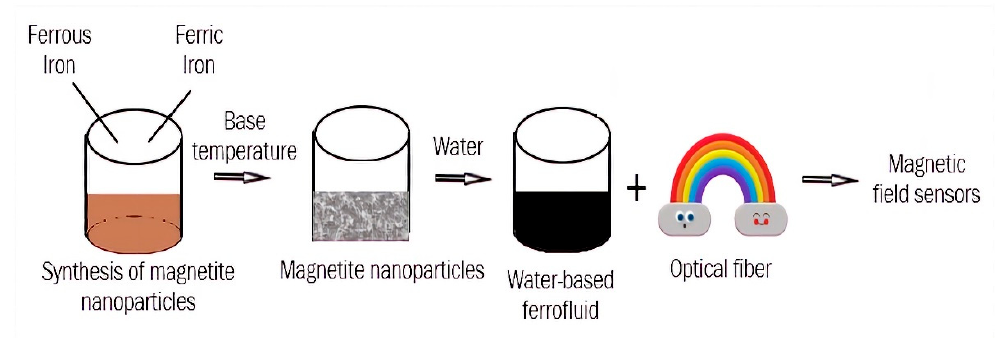
Figure 13. Schematic diagram of ( a ) the experimental setup for magnetic feld sensing and ( b ) the in-line Mach–Zehnder interferometer in tapered photonic crystal fiber (PCF), with single mode fiber (SMF) (adapted from [108] with permission from the Springer Nature). The process of magnetic field sensors’ fabrication is shown in Figure 14.